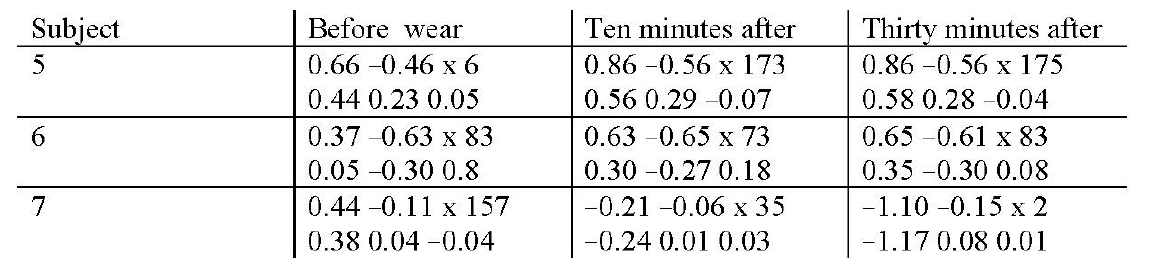
Table 4: Mean refractive state for three subjects (showing extreme changes